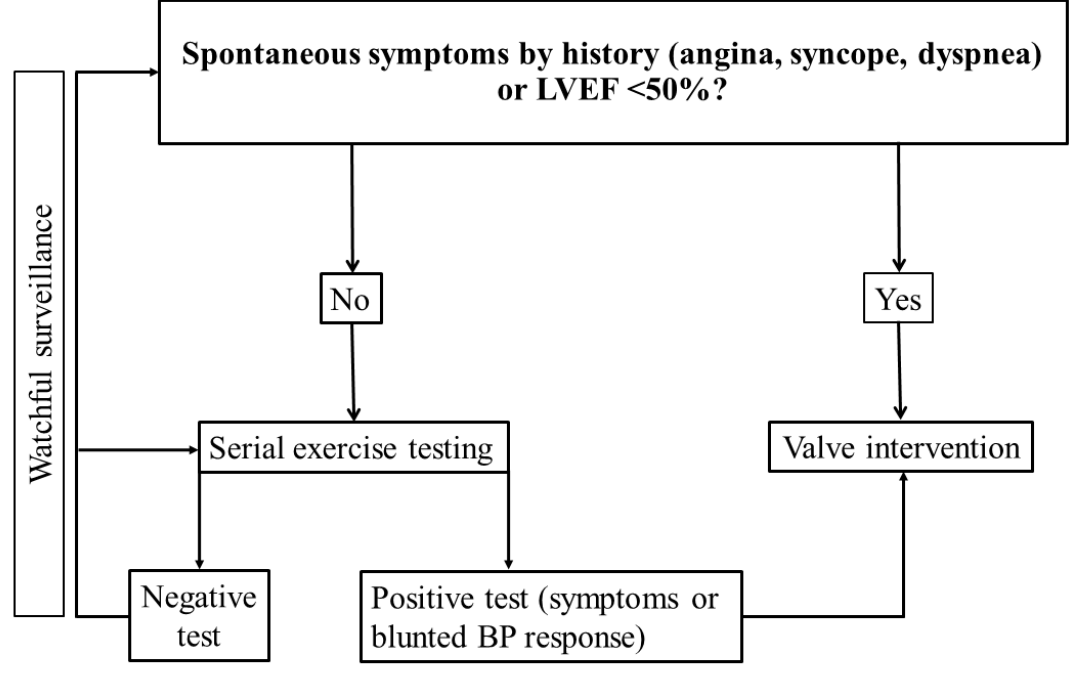
Figure 1. Management of aortic stenosis and the role of exercise testing in watchful waiting. BP, blood pressure; LVEF, left ventricular ejection fraction.